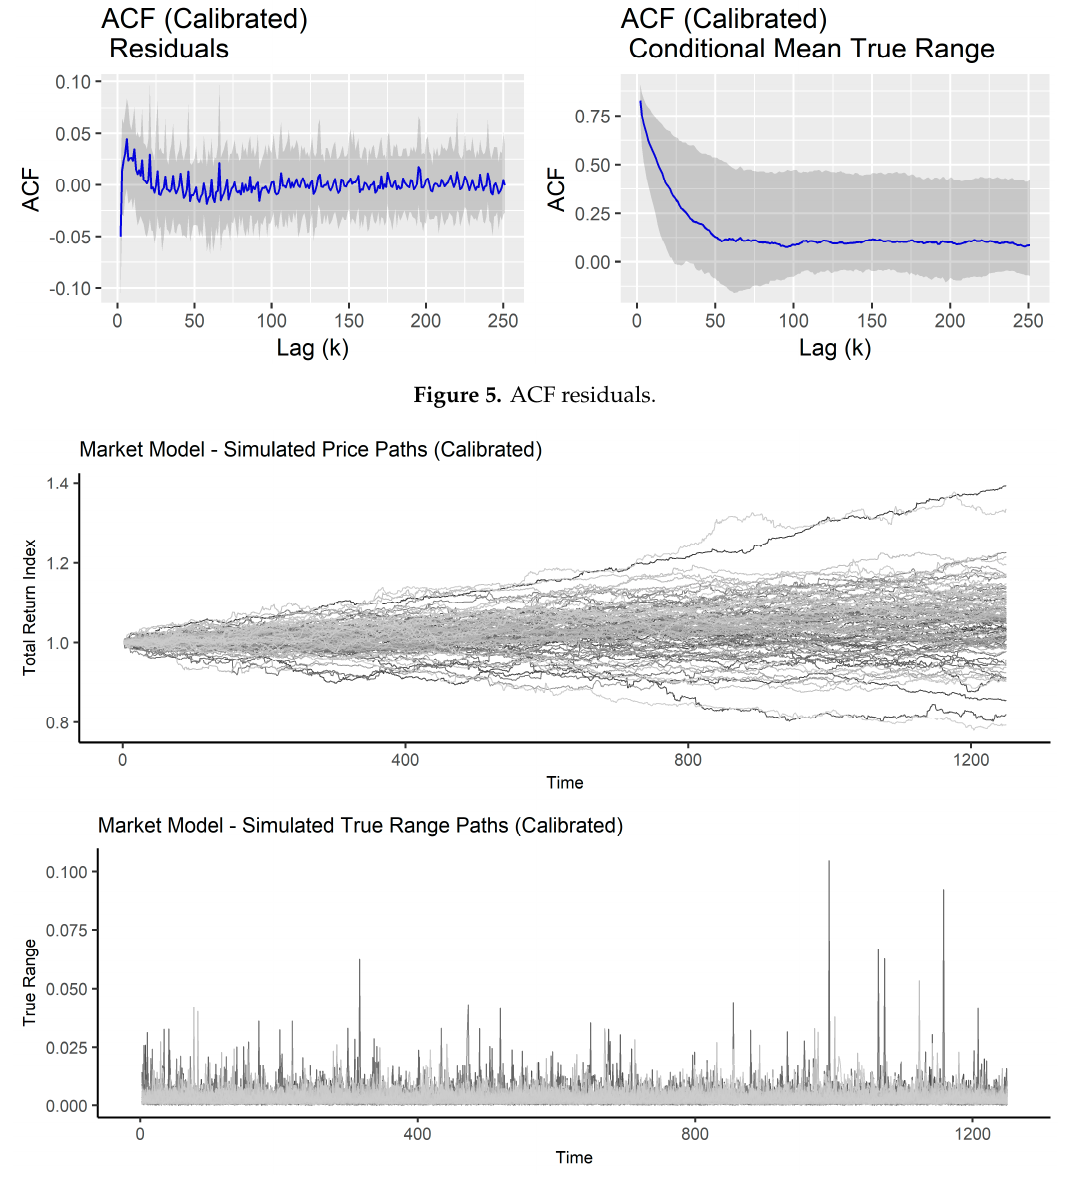
Figure 6. Market model simulated paths (calibrated to global futures) .